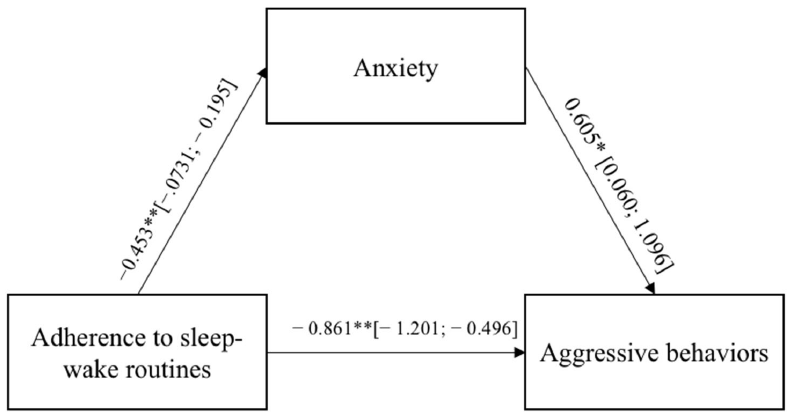
Figure 1. Results of Model 1. The bootstrap intervals of confidence are reported in brackets. * p < 0.05; ** p < 0.01; *** p < 0.001.